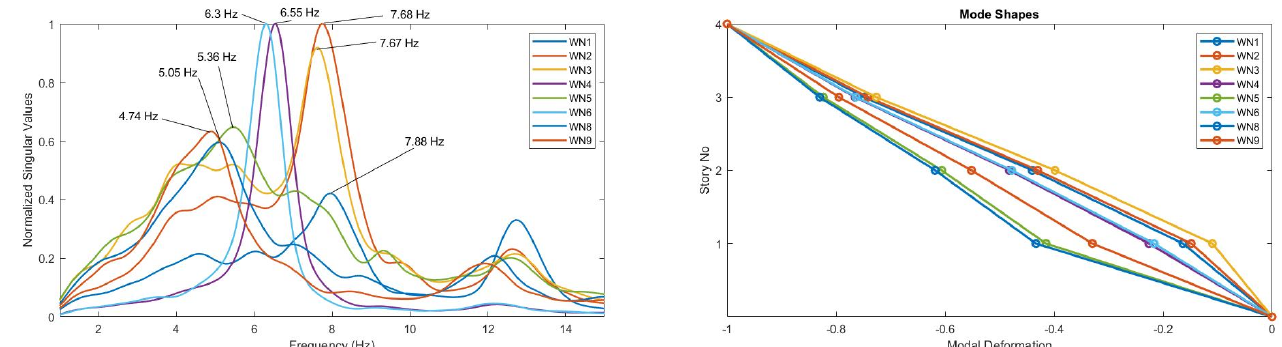
Figure 12. Dynamic identification results using noise − based evaluations from (E)FDD.